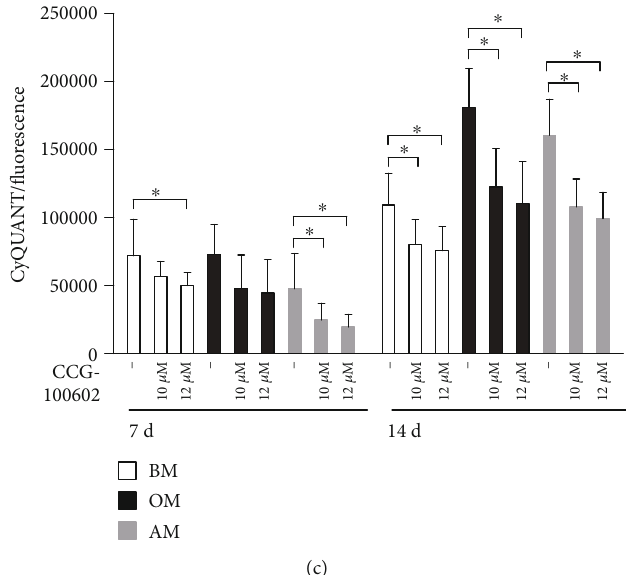
Figure 1: E ff ect of MRTF-A inhibition on viability and proliferation of hASCs. (a) Representative fl uorescence images of LIVE/DEAD-stained hASCs. hASCs were cultured 7d in BM, OM, or AM supplemented with 15, 20, 25, or 30 μ M CCG-1423 or 3, 8, 15, or 30 μ M CCG-100602 inhibitor, after which LIVE/DEAD analysis was performed. Green dye represents living cells (Alexa 488 fi lter), and a negligible number of dead cells are stained with red dye (Alexa 546). Scale bar 1.0mm, same scale in every image. (b, c) Proliferation of hASCs at 7 and 14d was analyzed with the CyQUANT method. The hASCs were cultured in BM, OM, or AM supplemented with 15, 20, or 25 μ M CCG-1423 inhibitor (b) or 10 or 12 μ M CCG-100602 inhibitor (c). N = 12 , independent biological replicates from 4 donors. 5% signi fi cance level was used in the statistical analysis, and the comparisons were made within a culture condition by comparing the inhibitor concentrations with the untreated medium control. BM: basic medium; OM: osteogenic medium; AM: adipogenic